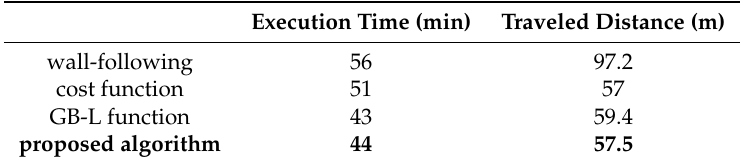
Table 4. Comparison of different exploration strategies according to execution time and traveled distance: wall-following, frontier-exploration with cost function, frontier-exploration with GB-L function and the proposed